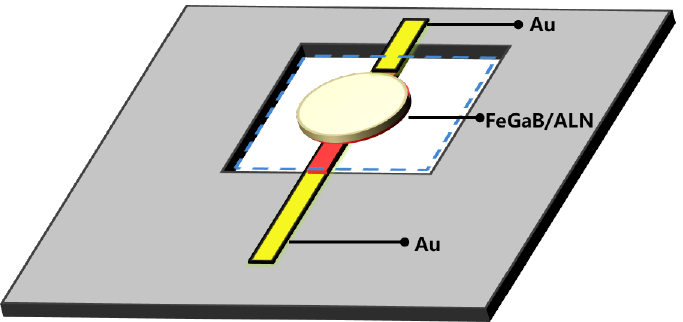
Figure 2. The structural dimensions of the developed MEMS magnetoelectric